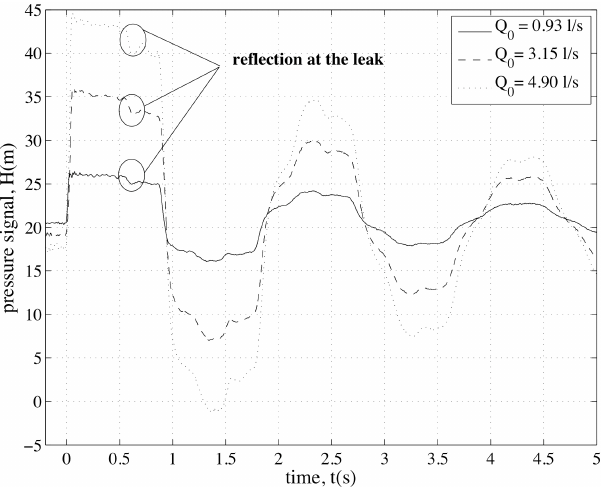
Figure 5. Damaged pipe with leak no. 2 (Table 1): pressure signal at section M for different values of the discharge at the end valve, Q 0 . 3